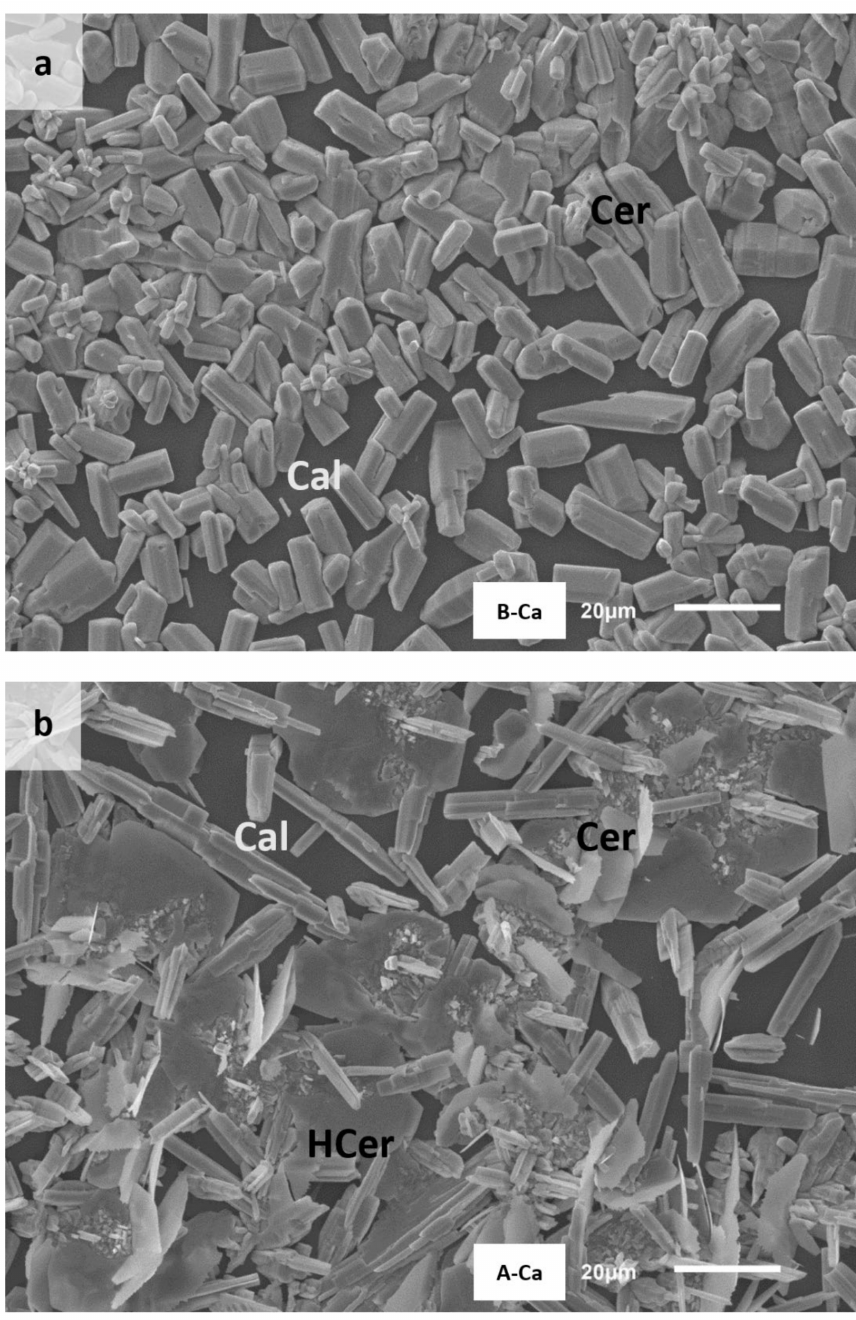
Figure 7. SEM micrographs of new phases formed after 24 h of interaction between Pb-bearing solutions and calcite crystals (Cal). ( a ) Cerussite (Cer) appears as prismatic crystals on calcite surface when calcite interacts with a solution with [Pb] i = 1 mM. ( b ) When the aqueous solution contains a higher Pb-bearing solution ([Pb] i = 10 mM), both prismatic cerussite (Cer) and hexagonal plates of hydrocerussite (HCer) form on calcite